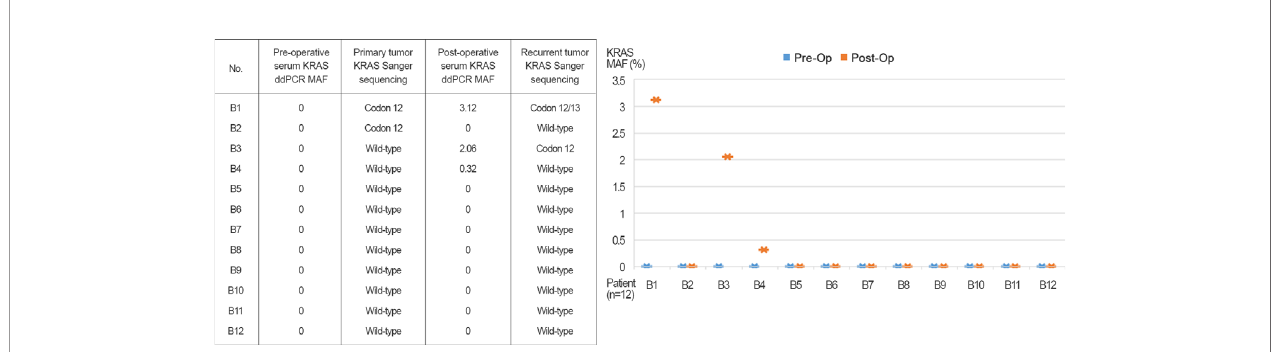
FIGURE 2 | Pre- and post-operative serum KRAS G12/13 detected by ddPCR and primary and recurrent (as distant metastasis)